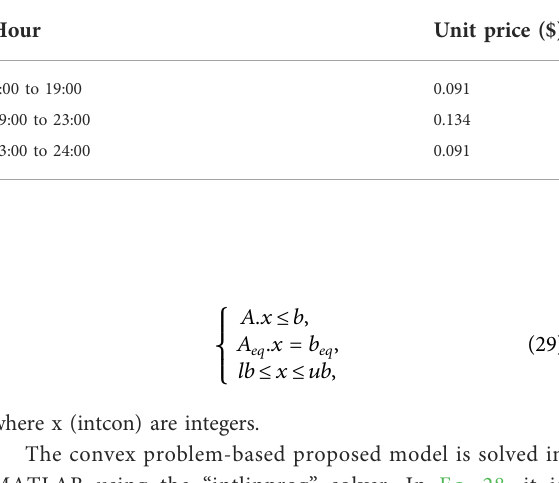
FIGURE 3 Flowchart of the proposed method.